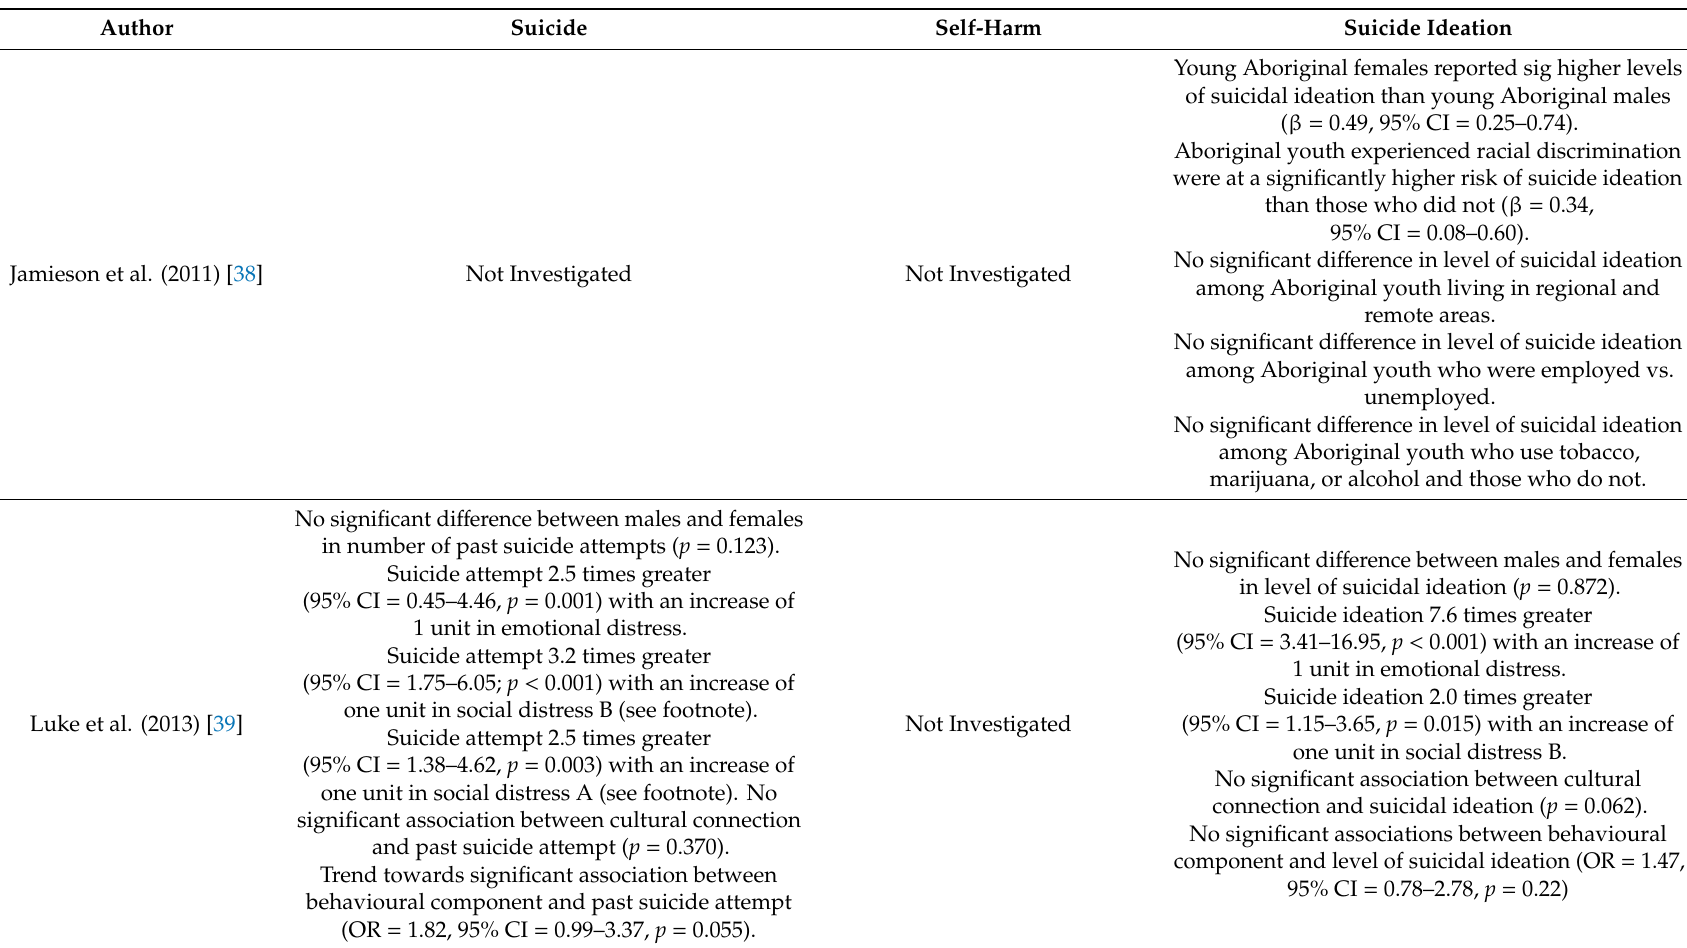
Table 4. Risk factors for suicide, self-harm and suicide